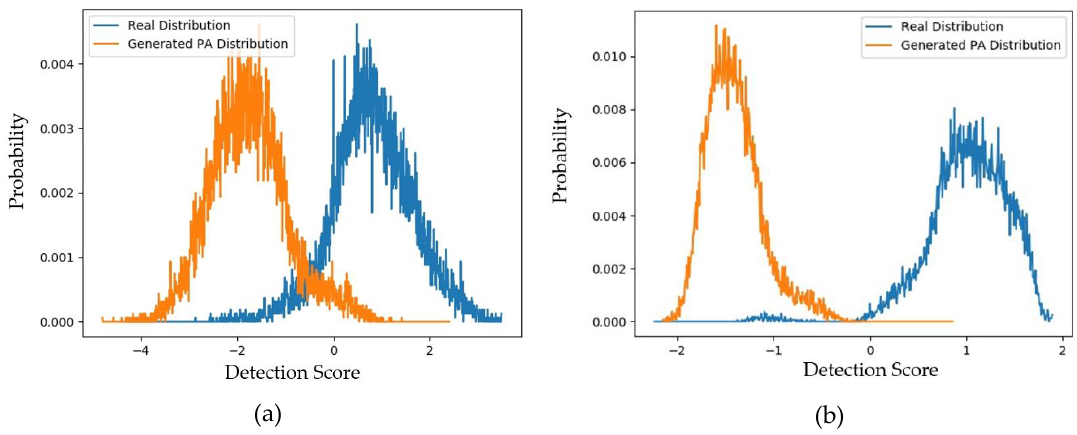
Figure 9. Distribution of detection score of captured real and generated PA images for the CASIA dataset ( a ) using hand-crafted-based face-PAD system [50] and ( b ) using deep-learning-based face-PAD system [15]. Table 8. PadD measurements of generated PA images using the CASIA dataset. Handcrafted-based PAD method [ 50 ]